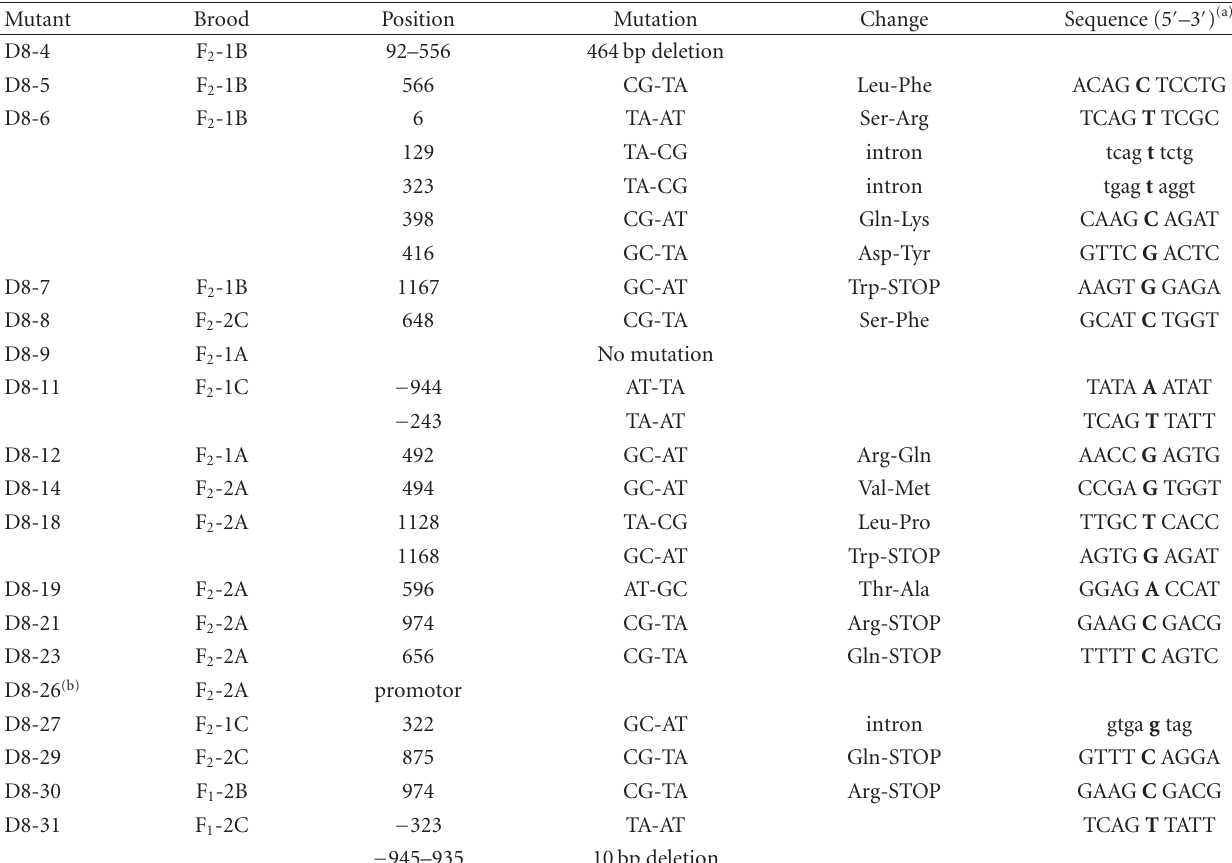
Table 2: Molecular characterization of v mutants induced by DES in postmeiotic male germ cells, under mus 308 − conditions. Mutant Brood Position Mutation Change Sequence (5 (cid:3) –3 (cid:3) ) (a)